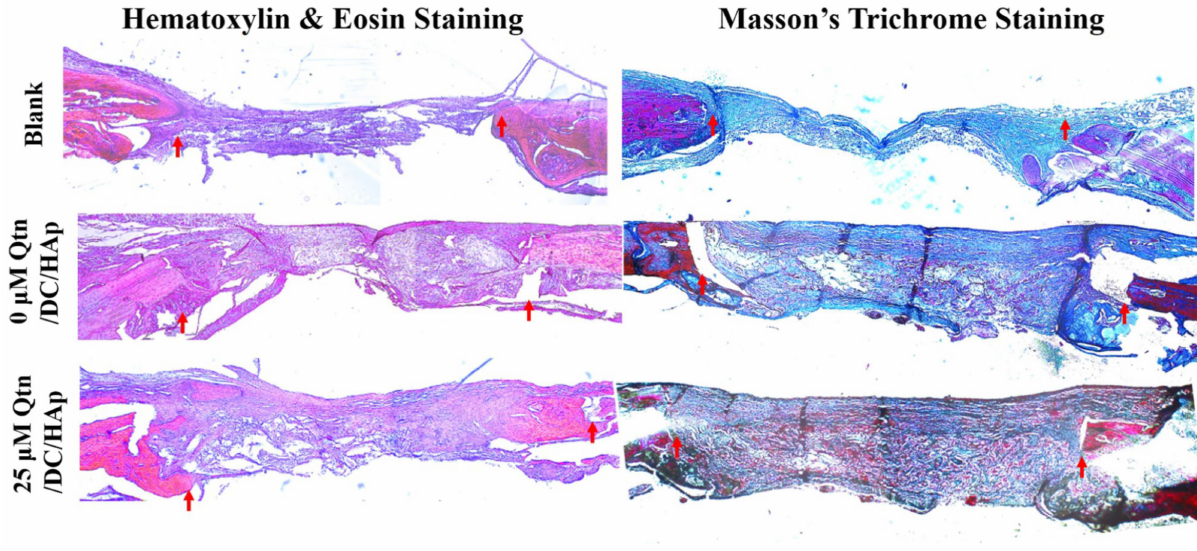
Figure 6. Histological evaluation of calvaria collected after 8 weeks of treatment with quercetin/collagen/hydroxyapatite sponges. (Red arrow indicates the edge of the defect at magnification × 40) (Reproduced with permission from [65] Copyright 2020,